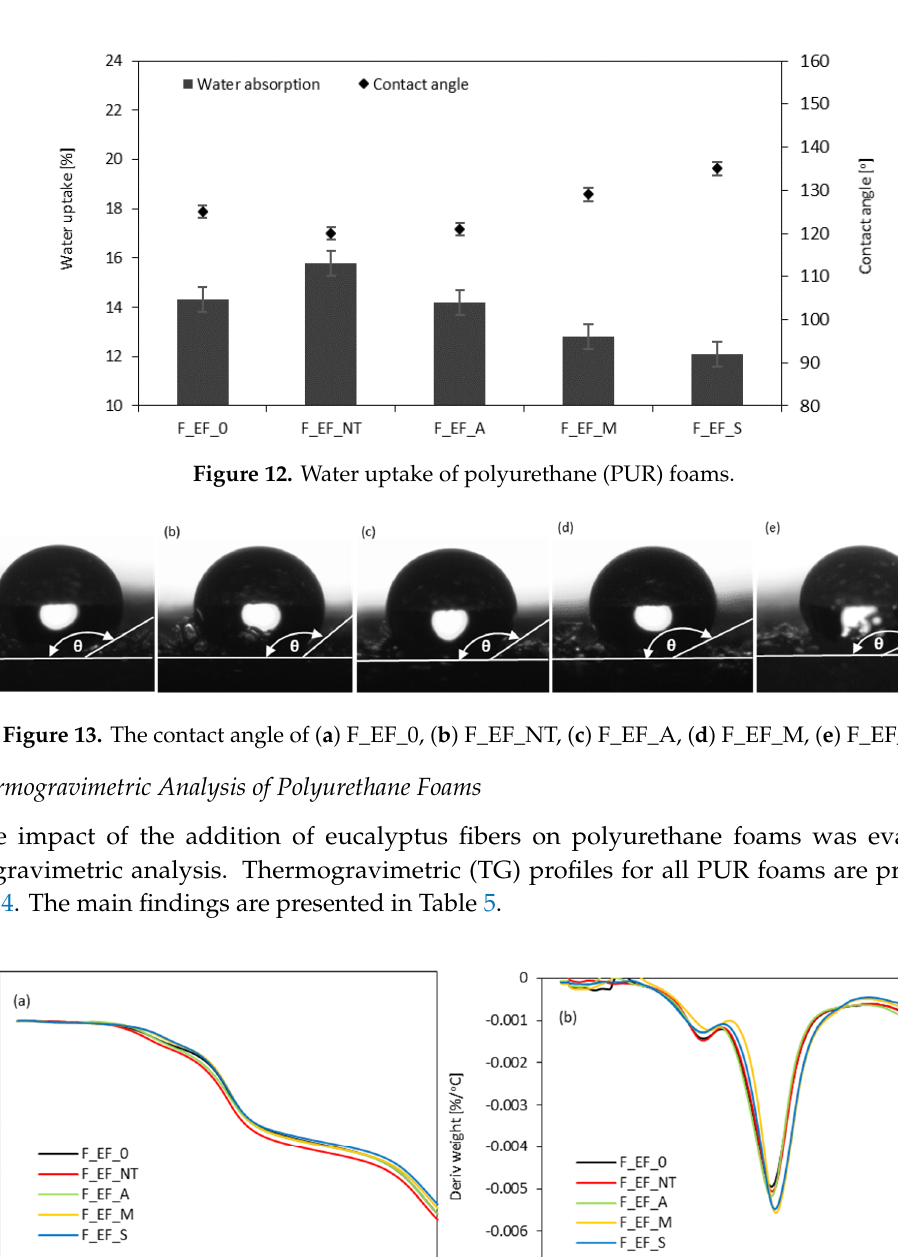
Figure 14. ( a ) TG and ( b ) DTG curves obtained for polyurethane foams modified with eucalyptus fibers. Table 5. The results of thermogravimetric (TG) and DTG